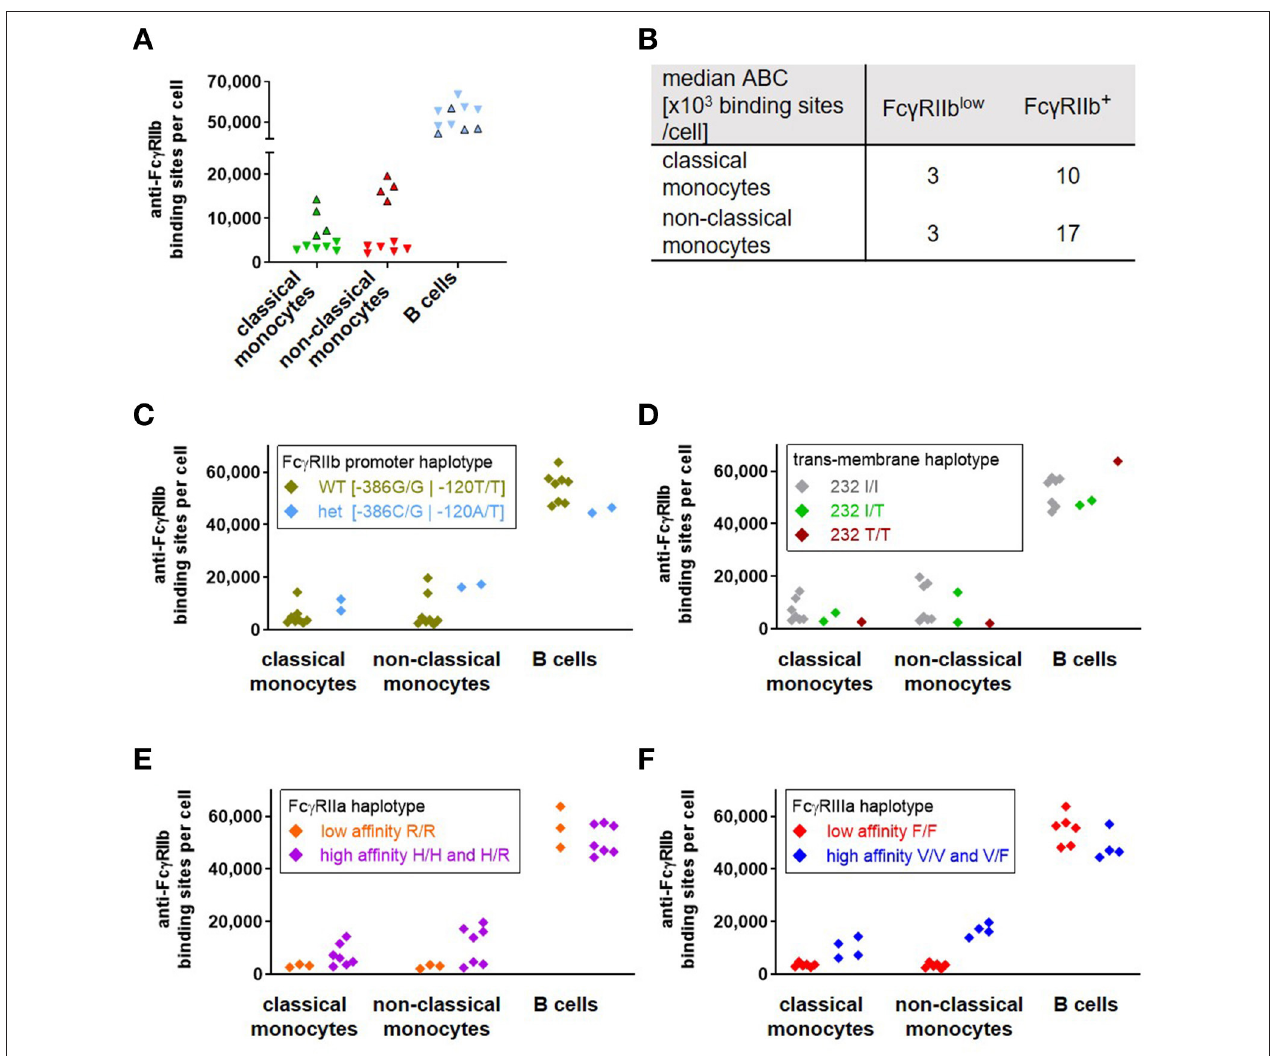
FIGURE 5 | Correlation of Fc γ RIIb expression with Fc receptor haplotypes in human donors. As depicted in (A) , a group of four of ten donors (Fc γ RIIb + , bordered triangles) revealed a significantly higher expression of Fc γ RIIb (given as anti-Fc γ RIIb binding sites per cell) on monocytes than the others(Fc γ RIIb low , inverted triangles without borders). Individual values are depicted for classical monocytes (green), non-classical monocytes (red) and B cells (blue). Median anti-Fc γ RIIb binding sites on monocyte subsets of Fc γ RIIb + and Fc γ RIIb low groups are depicted in (B) . (C–F) Anti-Fc γ RIIb binding sites on monocytes and B cells of the ten donors are grouped according their respective haplotypes for (C) the coupled − 386 − 120 promoter polymorphisms, (D) the isoleucine vs. threonine polymorphism at position 232 in the transmembrane region of Fc γ RIIb for homozygous I/I, T/T or heterozygous I/T donors, (E) the low affinity haplotype of Fc γ RIIa being homozygous with arginine at position 131 vs. the high affinity haplotype with at least one histidine allele and (F) the low affinity haplotype of Fc γ RIIIa, homozygous with phenylalanine at position 158 or the high affinity haplotype bearing at least one valine